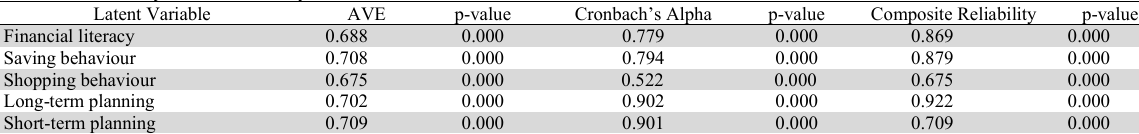
Construct Validity and